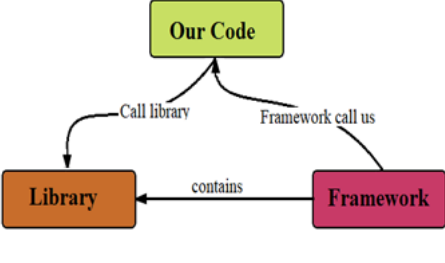
Fig. 4. Library-framework